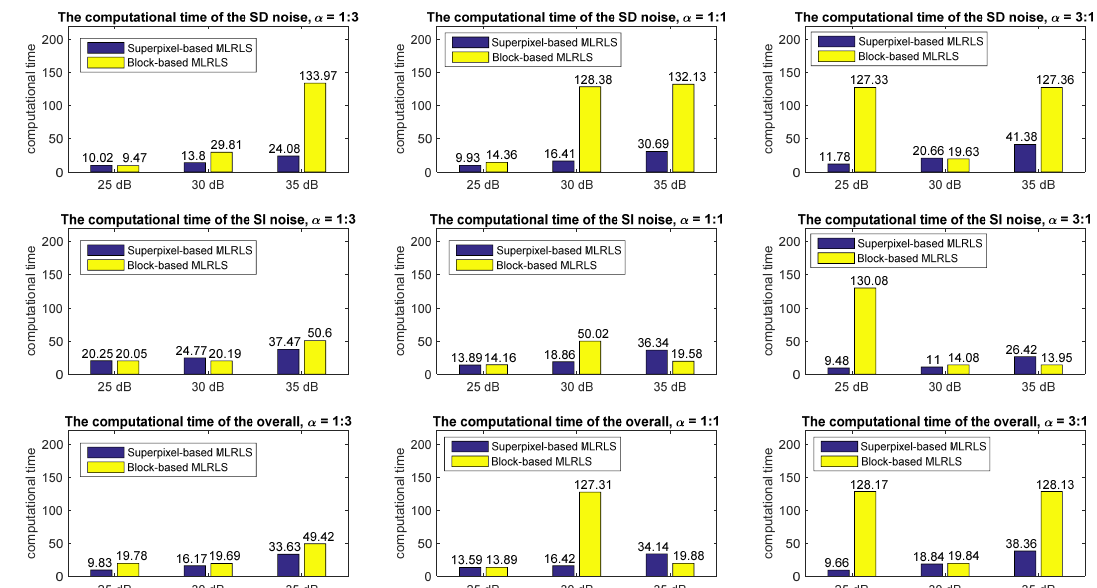
Figure 11. The computational time of the superpixel-based MLRLS and the block-based MLRLS (unit: second).